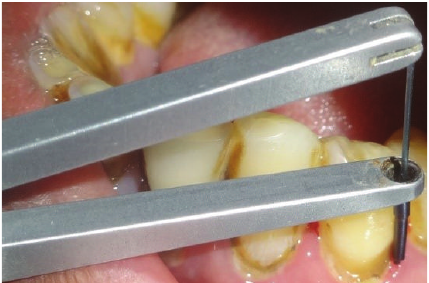
Figure 3: Florida probing alone in a randomized